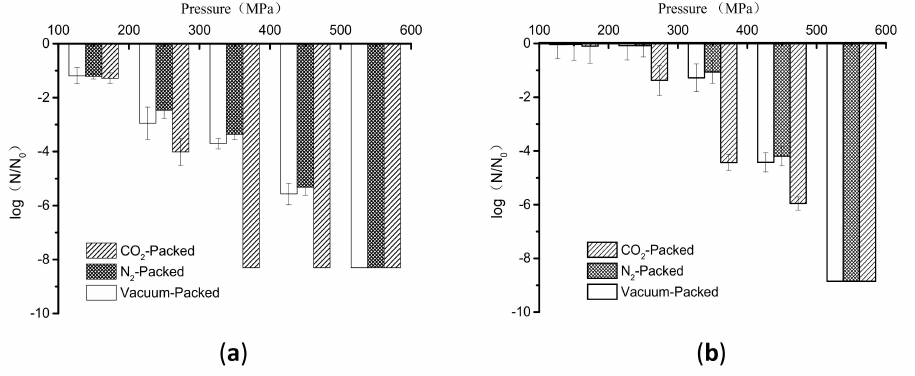
Figure 1. Inactivation of di ff erently packed E. coli cells suspended in physiological saline by treatment with di ff erent pressures ( a ); Inactivation of di ff erently packed E. coli suspended in lotus roots pulps by treatment with di ff erent pressures ( b